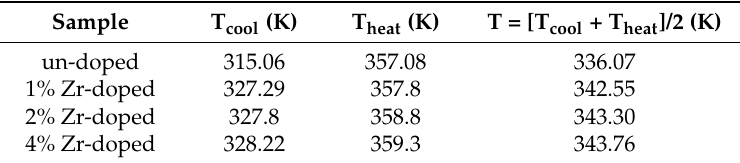
Table 2. Cooled (T cool ), heated (T heat ) and mean phase transition temperatures (T) calculated from moment vs. temperature curves of un-doped, 1% Zr-doped, 2% Zr-doped and 4% Zr-doped VO 2